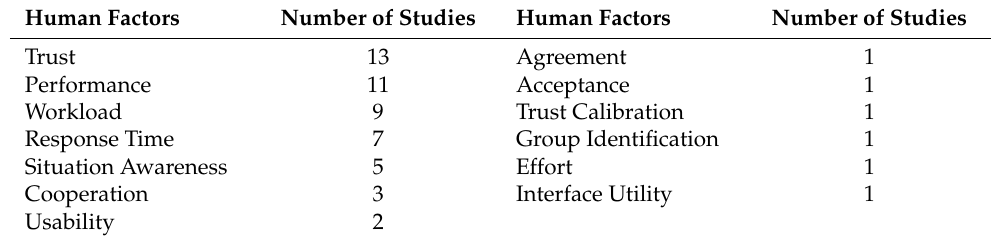
Table 5. The HF investigated in the HAT research area from 2014 to 2021. Human Factors Number of Studies Human